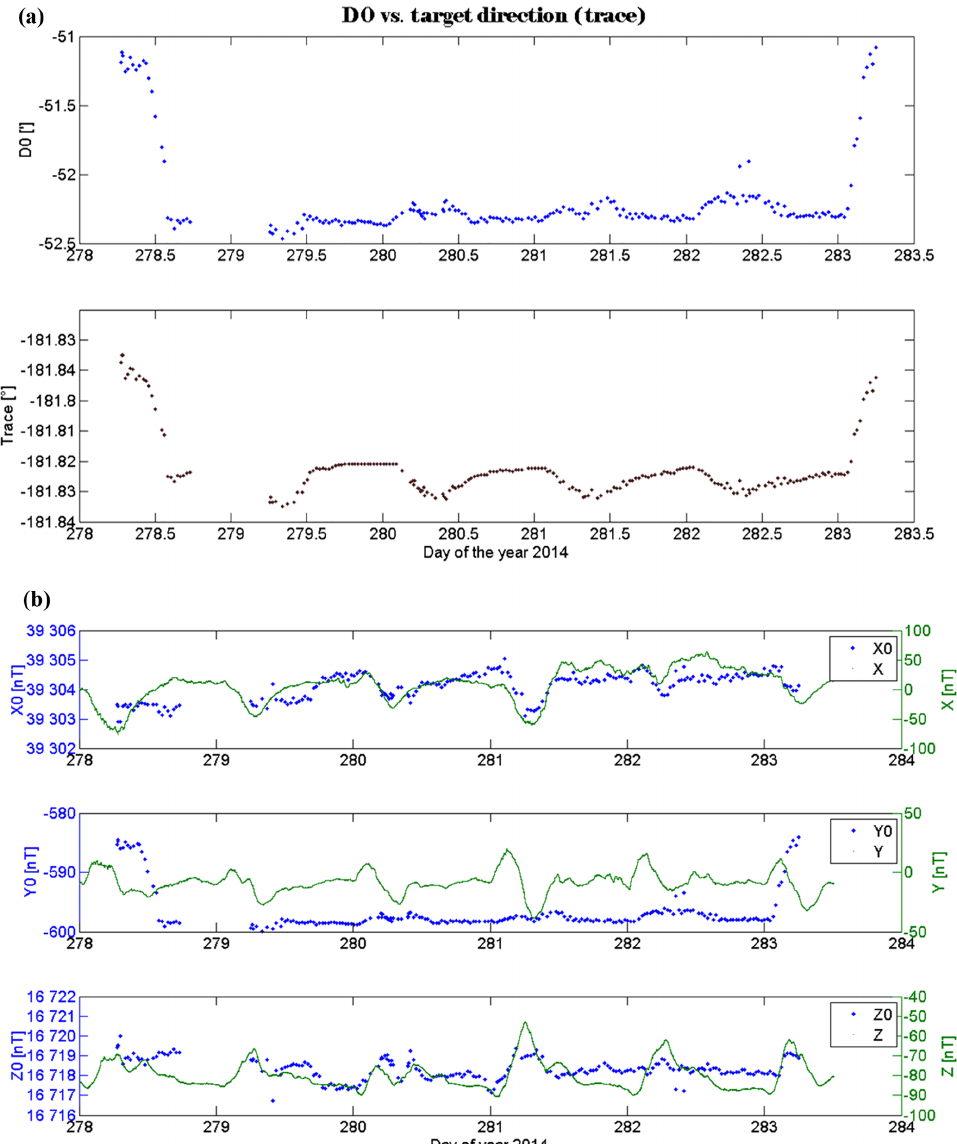
Figure 9. (a) Drift of the target in front of D0 variation. (b) Variometer diurnal variation (green curve) due to bad scale factor or misalignment of the